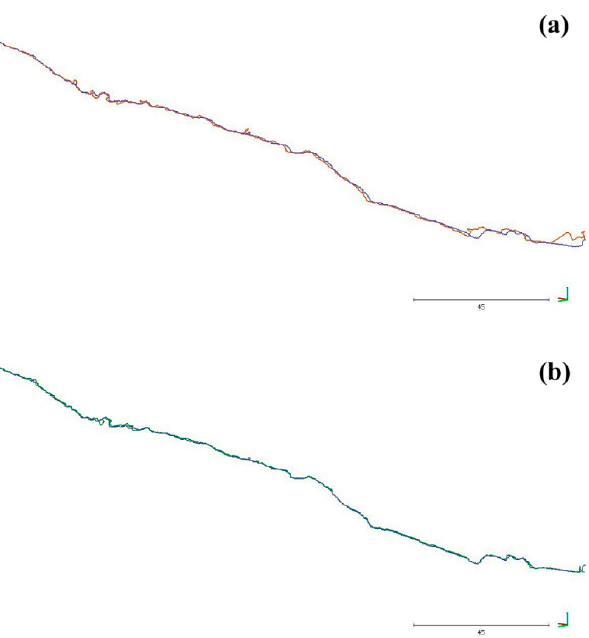
Figure 12. Surface profiles. ( a ) Surface profile of the nadir-viewing point cloud (orange line) in accordance with the respective surface profile of the point cloud from nadir-oblique imagery (blue line). ( b ) Surface profile of the oblique-viewing point cloud (green line) in accordance with the respective surface profile of the point cloud from nadir-oblique imagery (blue